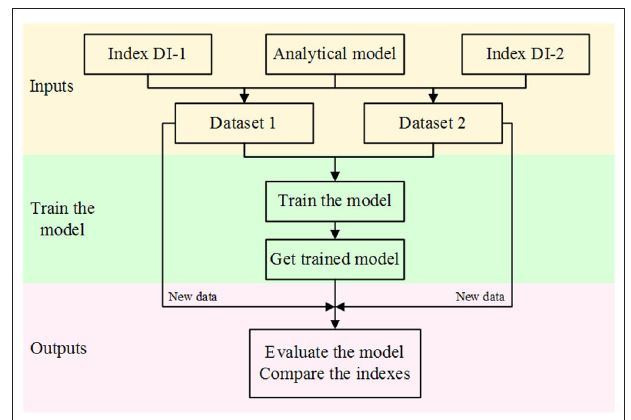
FIGURE 6 | Flowchart of the identification process.